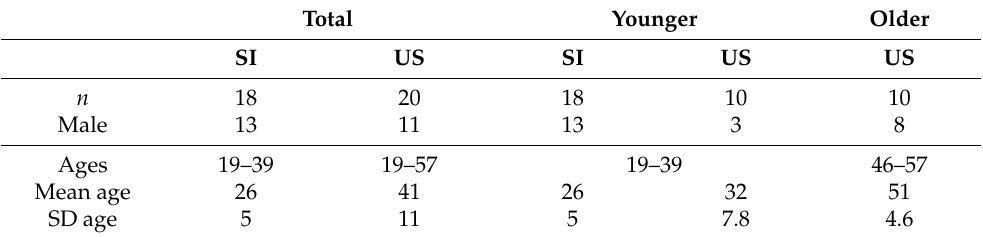
Table 1. Participant demographics for Slovenia (SI) and USA